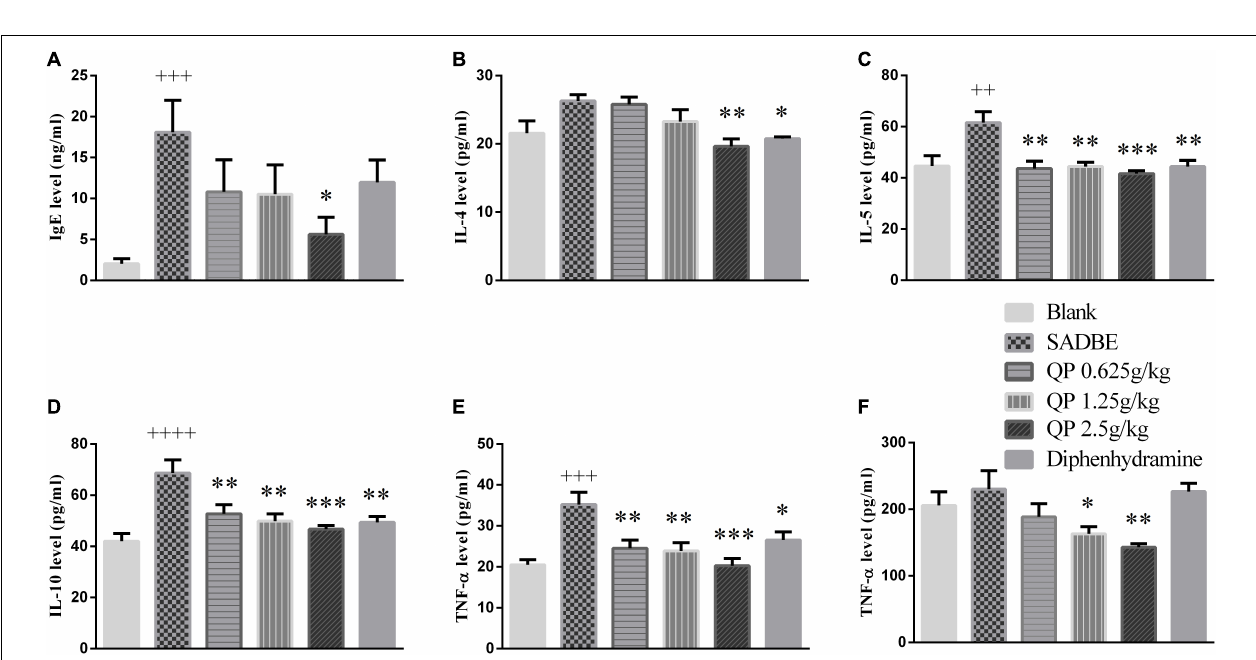
FIGURE 8 | Effect of QP on the levels of different cytokines or IgE in the serum or spleen of SADBE mice. Among them, (A–E) showed the levels of IgE, IL-4, IL-5, IL-10, and TNF- α in the serum of each group, and (F) showed of TNF- α in the spleen of each group. ∗ p < 0.05, ∗∗ p < 0.01, and ∗∗∗ p < 0.001, compared to the model group. ++ p < 0.01, +++ p < 0.001, and ++++ p < 0.0001, compared to the blank control group. ANOVA ( n = 5 each group).